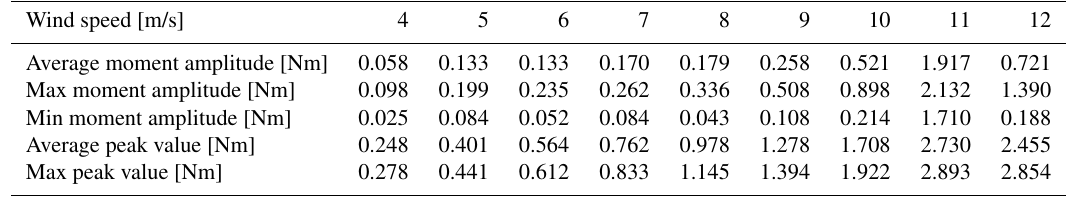
Table 2. Case A testing parameters of bending moments for wind speed range.